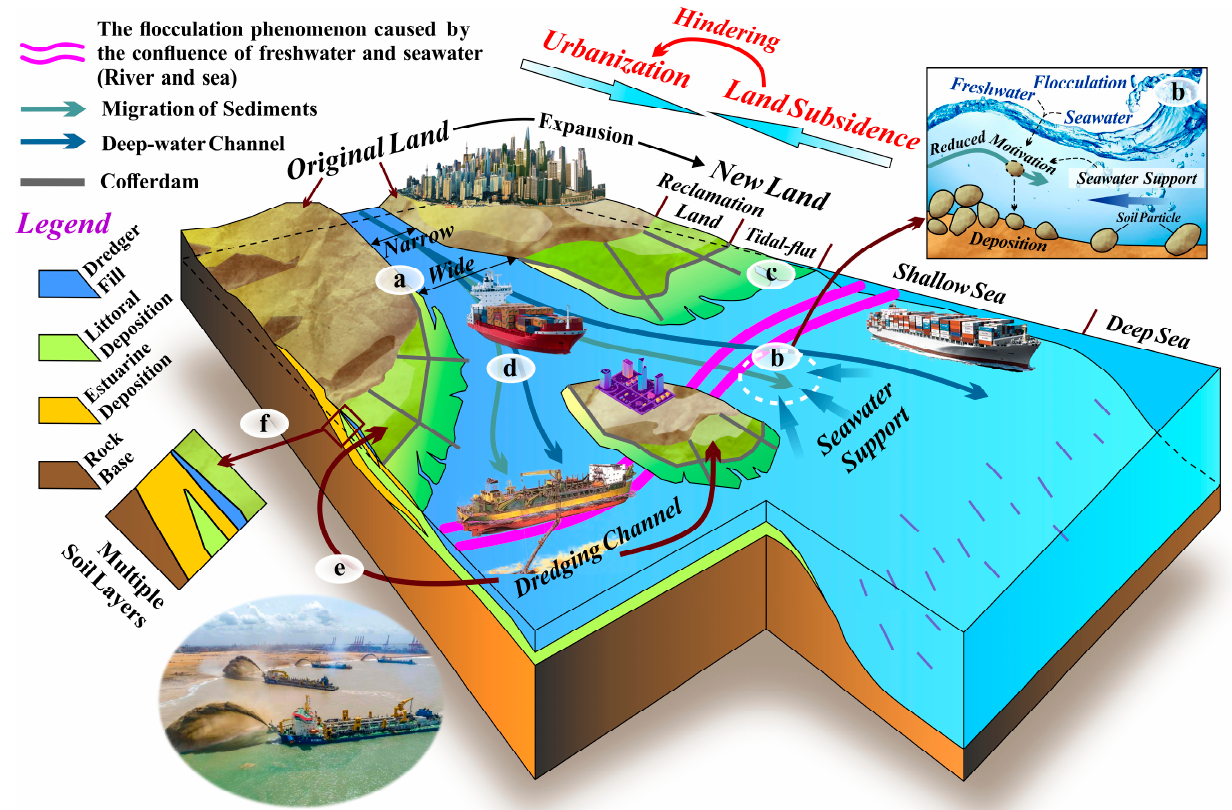
Figure 1. A sketch of the expansion of Shanghai’s coastal land. ( a ) The widened Yangtze River; ( b ) the joint effects of seawater support and flocculation; ( c ) the expanding new lands; ( d ) the vessels on the voyage; ( e ) hydraulic reclamation; ( f ) multiple soil layers.